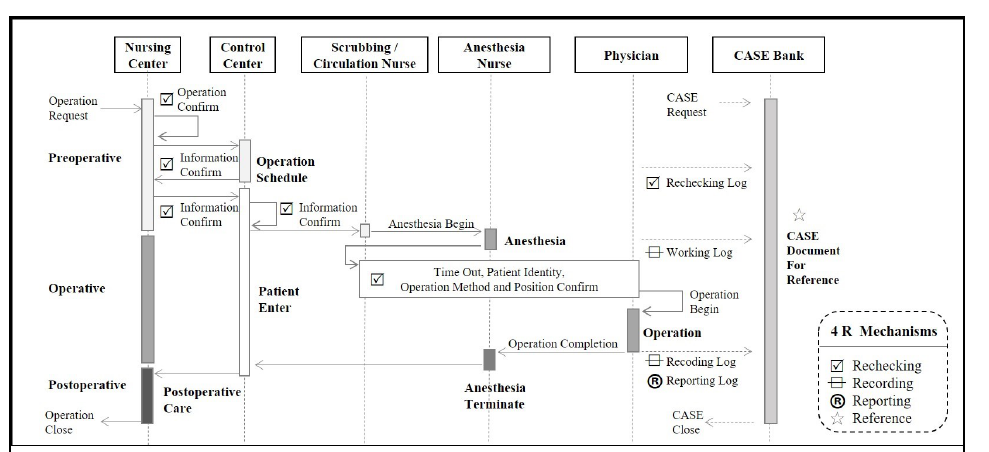
Figure 1. The process and information flow of surgical information system